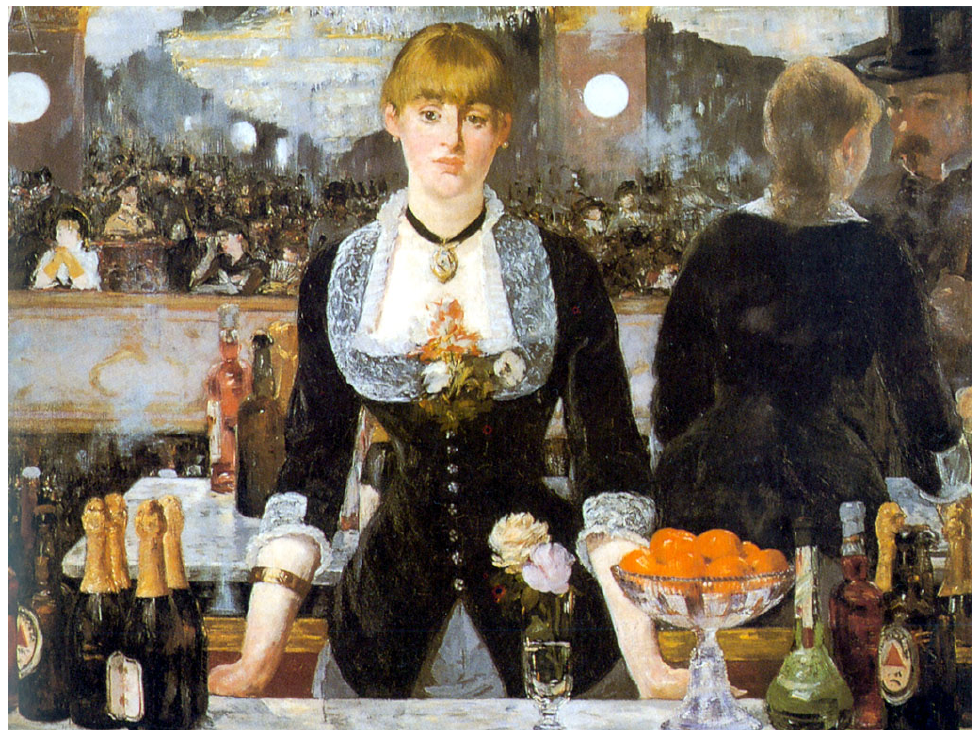
Figure 5: Edouard Manet: Bar aux Folies-Bergère , 1882, © The Samuel Courtauld Trust, The Courtauld Gallery,